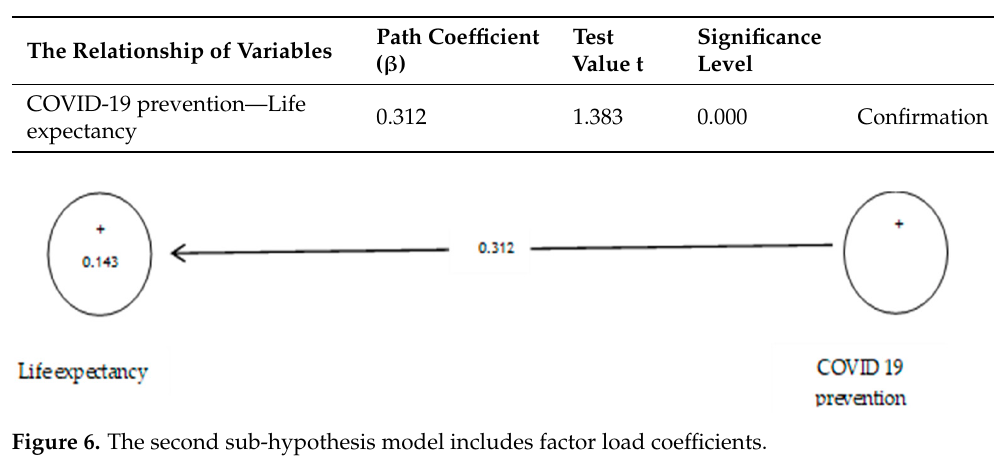
Table 6. Evaluation indicators of the internal model of the research, direction and significance of direct effects.